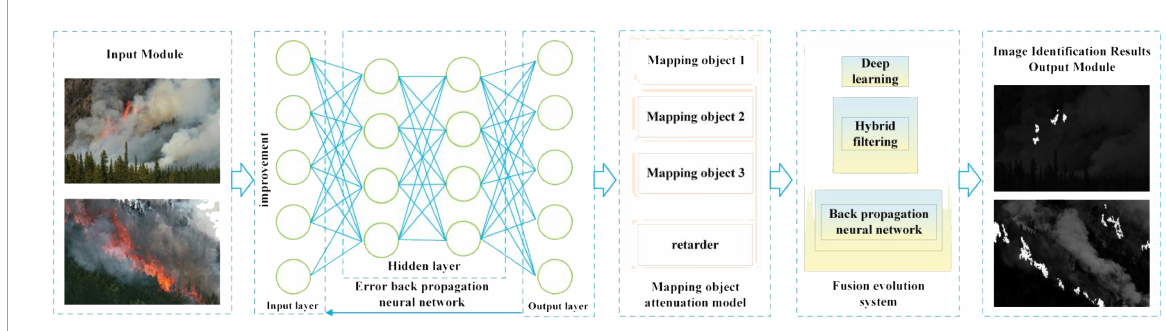
FIGURE1 Modified machine learning algorithm network model structure.